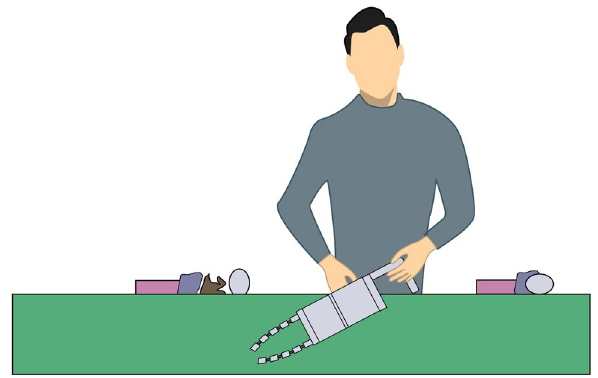
Fig. 13 First integration strategy: handling